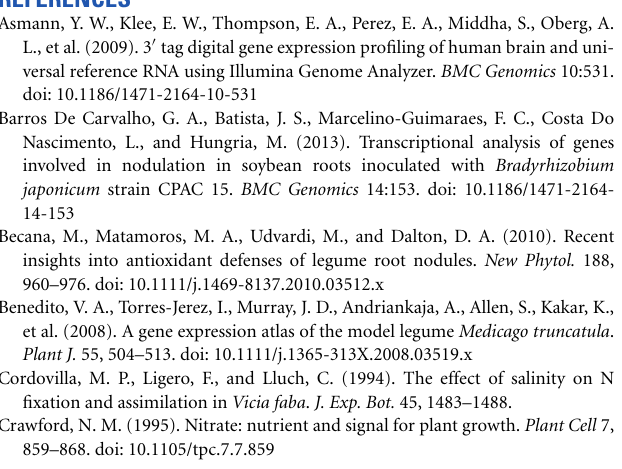
of this gene in nodule tissue underlines the importance of NAD as redox carrier in the rhizobia-adapted